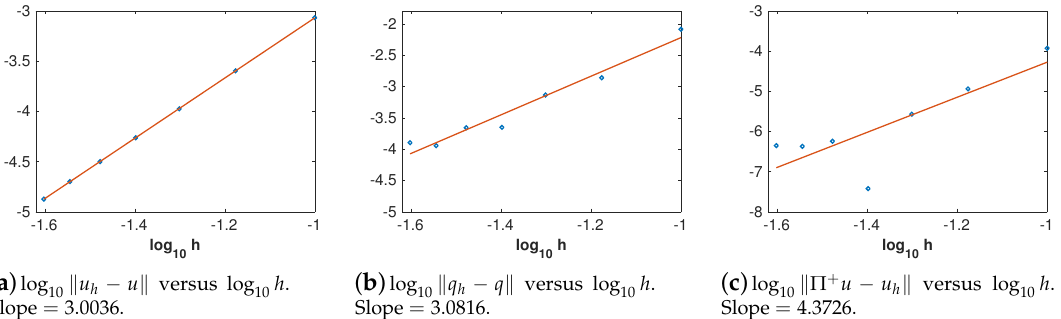
h , where E is the L 2 error at T = 0.5 with P 2 basis. Figure 2. log E versus log 10 10